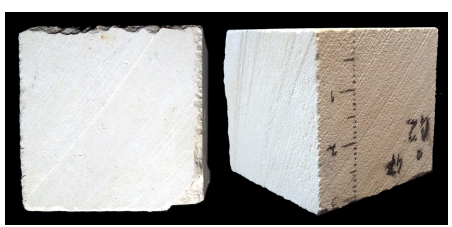
Figure A1. Example of the Ançã stone samples used for this study.